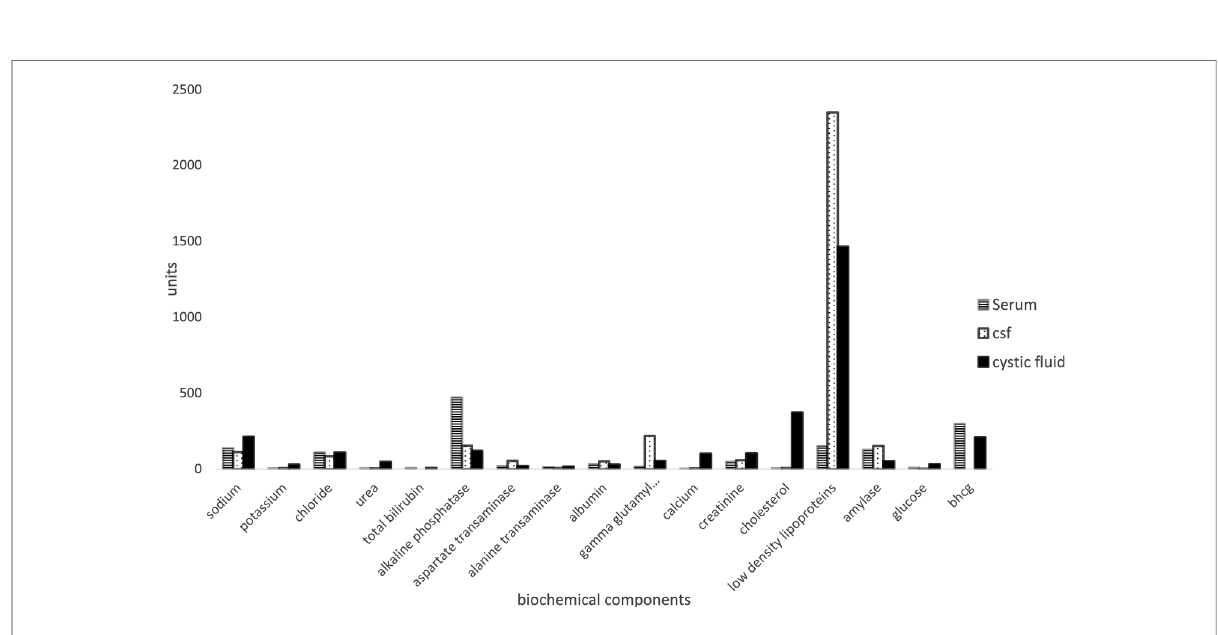
FIGURE 3 Relative concentrations between cystic fl uid, serum, and